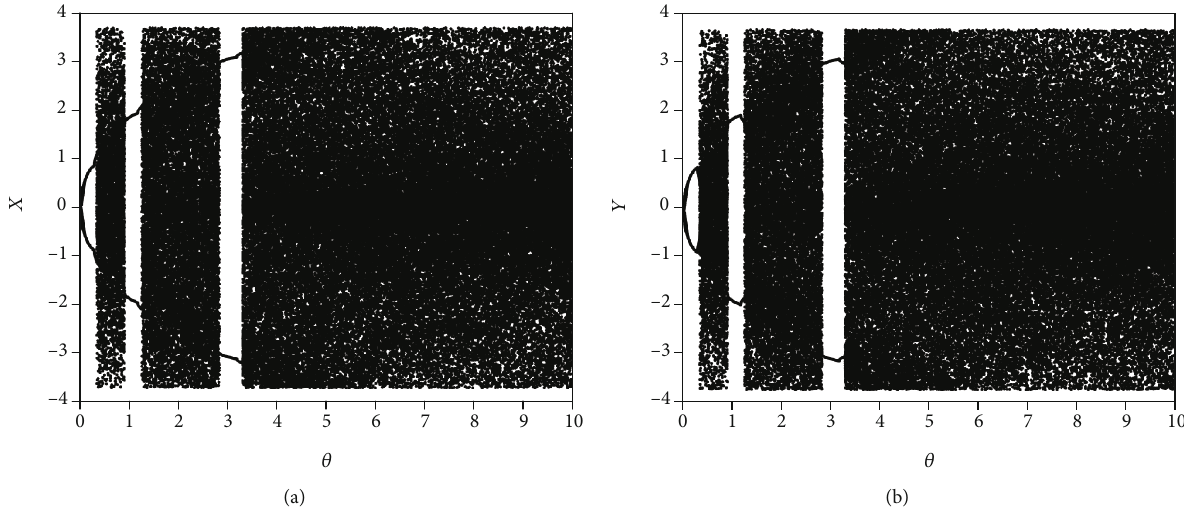
Figure 2: Bifurcation diagram of 2D SF-SIMM. (a) Bifurcation diagram of sequence X with η = 3 : 7 and λ = 2 : 6 . (b) Bifurcation diagram of sequence Y with η = 3 : 7 and λ = 2 : 6 .